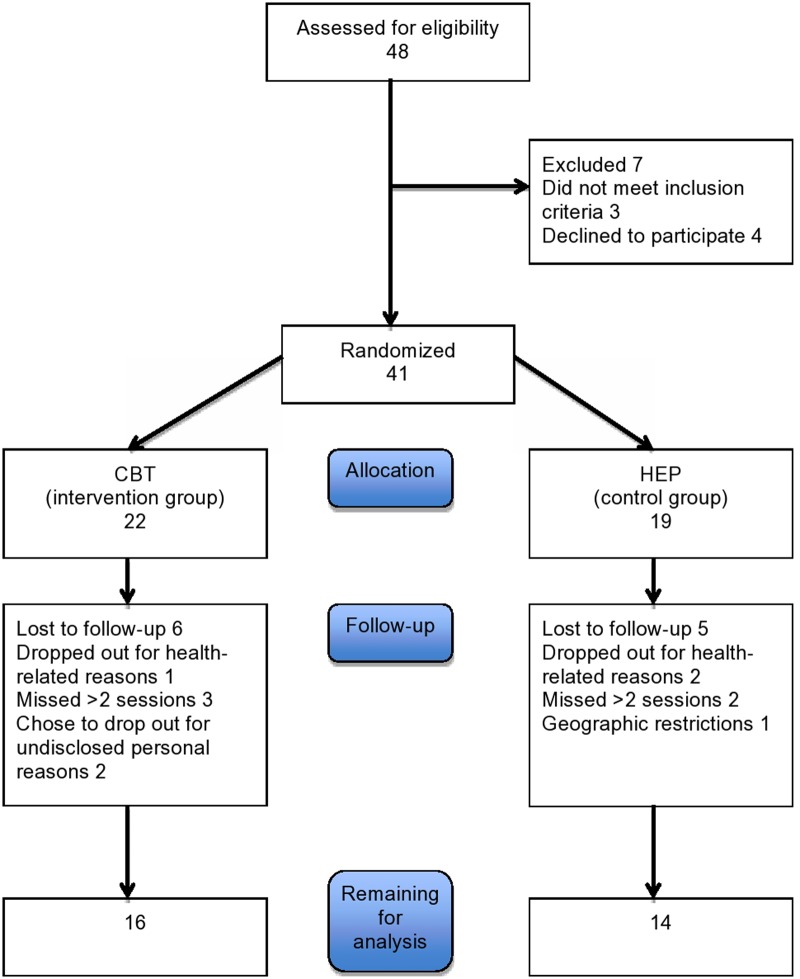
Participant flow.